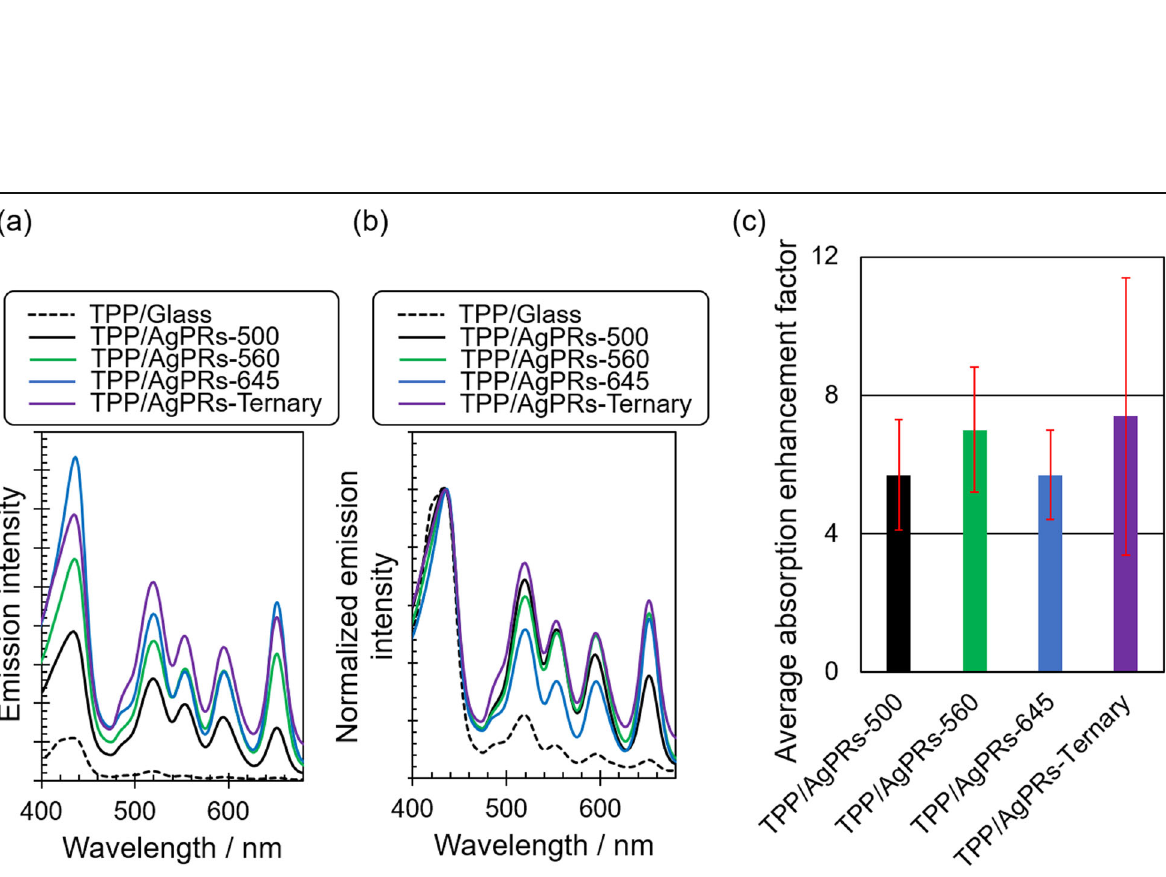
Fig. 6 a Fluorescence excitation spectra as measured. b Normalized fluorescence excitation spectra ( λ em = 720 nm). c Average absorption enhancement factors of TPP/glass, TPP/AgPRs-500, TPP/AgPRs-560, TPP/AgPRs-645, and TPP/AgPRs-ternary. The red lines indicate the standard deviations for the measurements repeated three